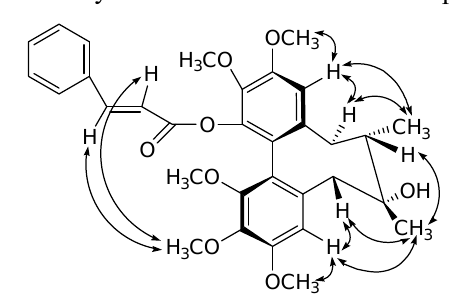
Figure 3 . Key NOESY Correlations of compound